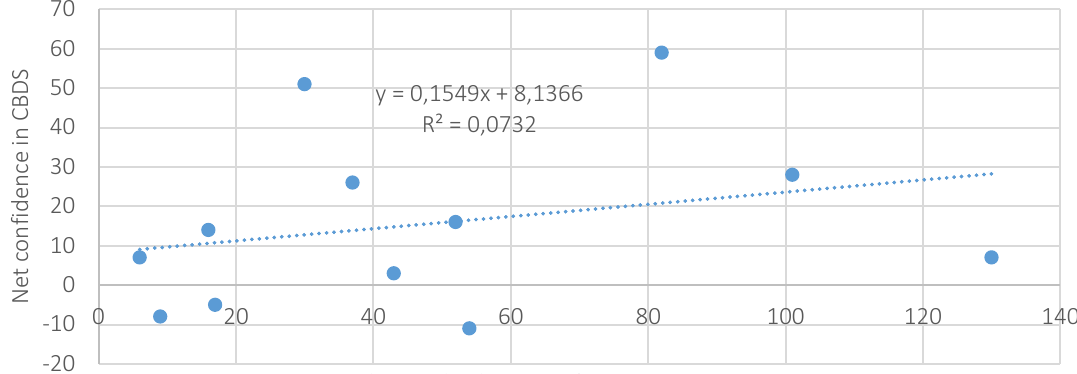
Figure В1. Confidence in CBDC and power distance